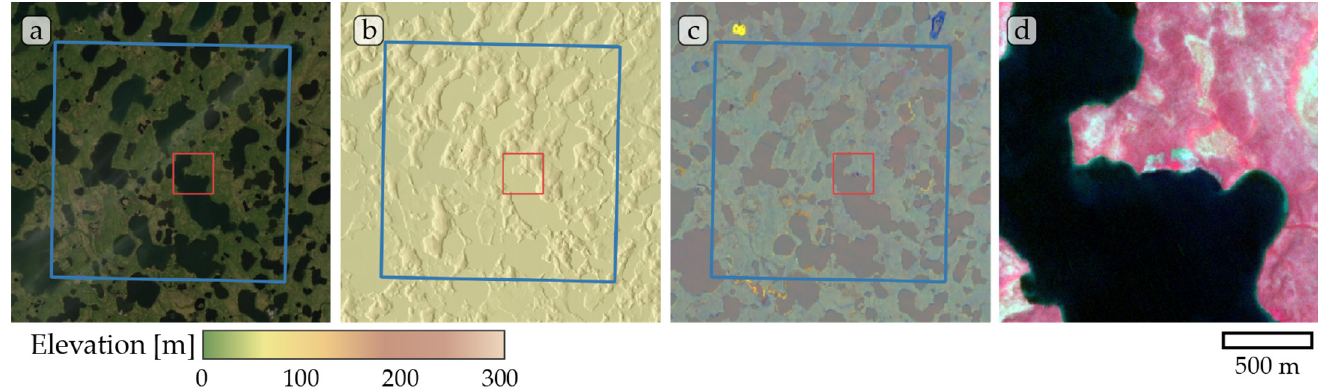
Figure A8. Study site Lena. ( a ) ESRI satellite layer, ( b ) ArcticDEM superimposed with hillshade, ( c ) Tasseled Cap trend visualization, ( d ) PlanetScope satellite image (NIR-R-G) acquired on 31 July 2019. Blue box, 10 × 10 km study site. Red box detailed view of ( d ).